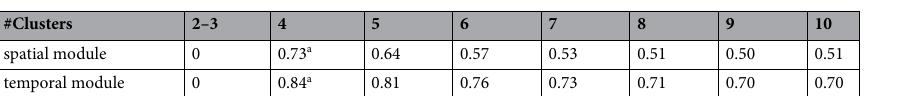
Table 2. Silhouette value in each number of clusters. The number of clusters for the spatial and temporal modules was defined as 4 based on the largest silhouette value. a Indicates the optimal number of clusters.